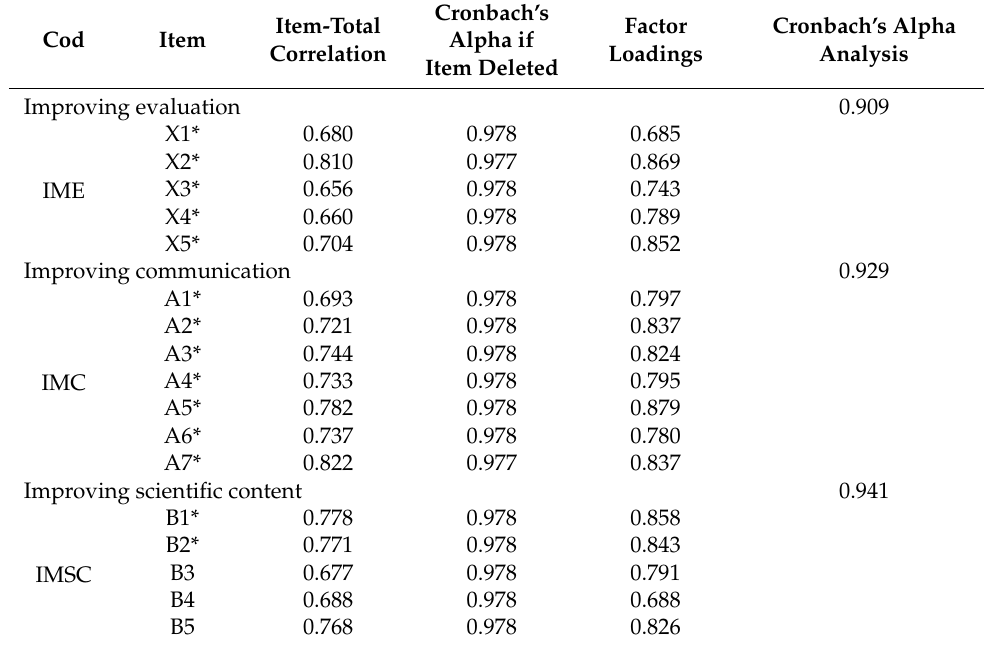
Table 6. Results of reliability